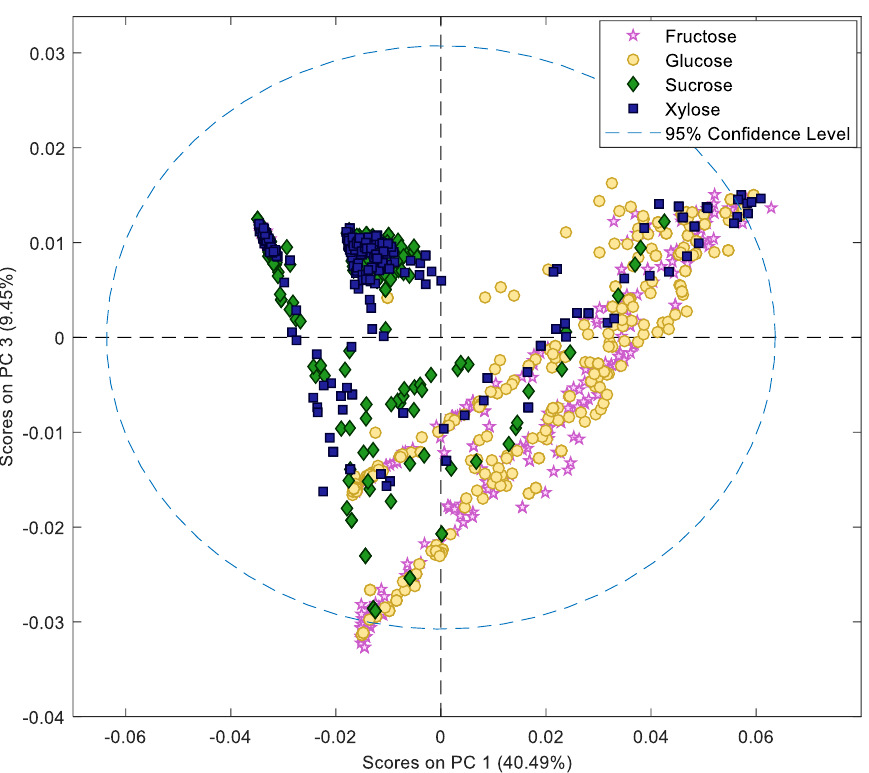
Figure 1. PCA score of 1 H NMR data of aqueous extracts of in vitro Rhizopus stolonifer cultures. The PCA score plot shows the separation of samples based on sugar sources (glucose, fructose, sucrose, and xylose) regardless of isolates and nitrogen sources.